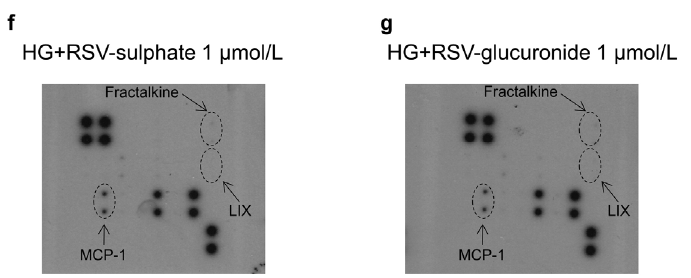
Figure 1. Analysis of neonatal fibroblast culture media. Average values ± standard error of the mean SEM of pro ‐ inflammatory cytokines expressed by neonatal cardiac fibroblasts ( a – c ) cultured in normoglucidic (Glucose 5.5 mmol/L), hyperglucidic (HG, High Glucose: 25 mmol/L) or hyperglucidic + RSV metabolites medium. * p < 0.05 vs. normoglucidic conditions. § p < 0.05 vs. HG conditions (one ‐ way ANOVA, Holm ‐ Šídák post test); Panels ( d – g ) typical images obtained with RayBio Rat Cytokine Antibody Array 1. The membranes were probed with conditioned media from neonatal cardiac fibroblasts cultured in different conditions. Membranes were exposed to Kodak X ‐ Omat AR film. MCP-1: Monocyte chemotactic protein-1; LIX: Lipopolysaccharide-inducible CXC chemokine.